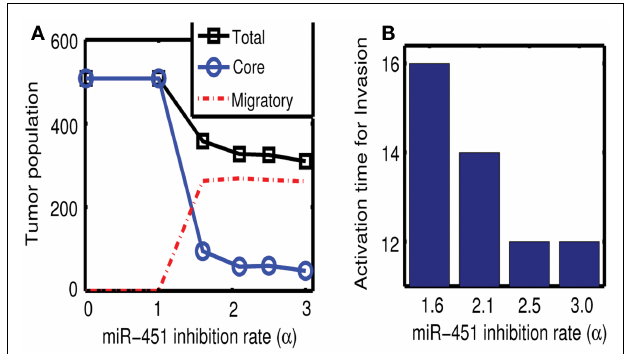
FIGURE 7 | (A) Effect of miR-451 inhibition strength ( α ) on tumor population. As α is increased, miR-451 production rate is decreased leading to low miR-451 activity and activation of glioma cell migration. (B) Effect of α on activation time for cell invasion. As α is increased, lowered miR-451 activity leads to early activation of cell invasion. See Appendix A.2 for definition and role of α in the core system.